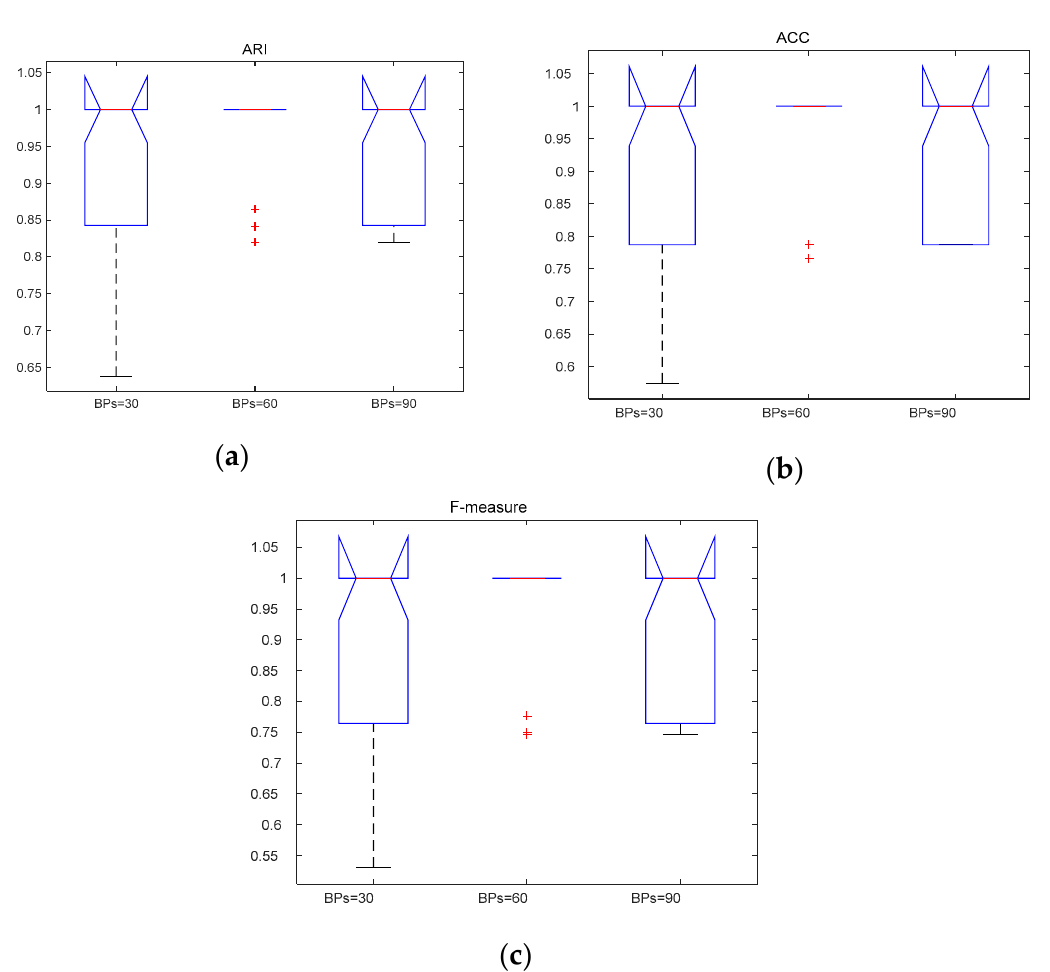
Figure 7. Boxplots of Adjusted Rank Index (ARI), Clustering Accuracy (ACC), and F_measure by DCHP-FCC algorithm on Soybean-small dataset with basic partitions (BPs) equal to 30, 60 and 90, respectively.